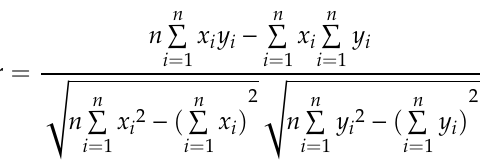
(EALM) and NREL’s FAST code at different wind speeds.